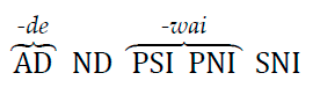
Figure 15. Reference Hierarchy for Nubi.